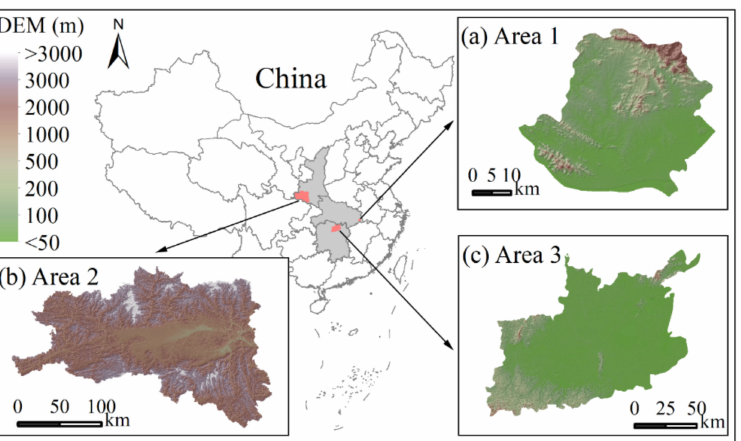
Figure 1. Locations of the study areas. ( a ) The first study area, Hubei Province. ( b ) The second study area, Shanxi Province. ( c ) The third study area, Hunan Province.